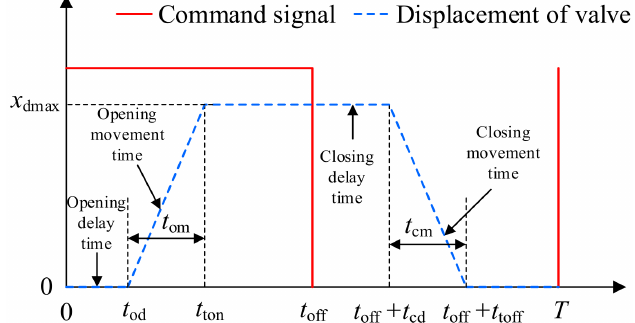
Figure 3. Dynamic characteristics of the digital valve.